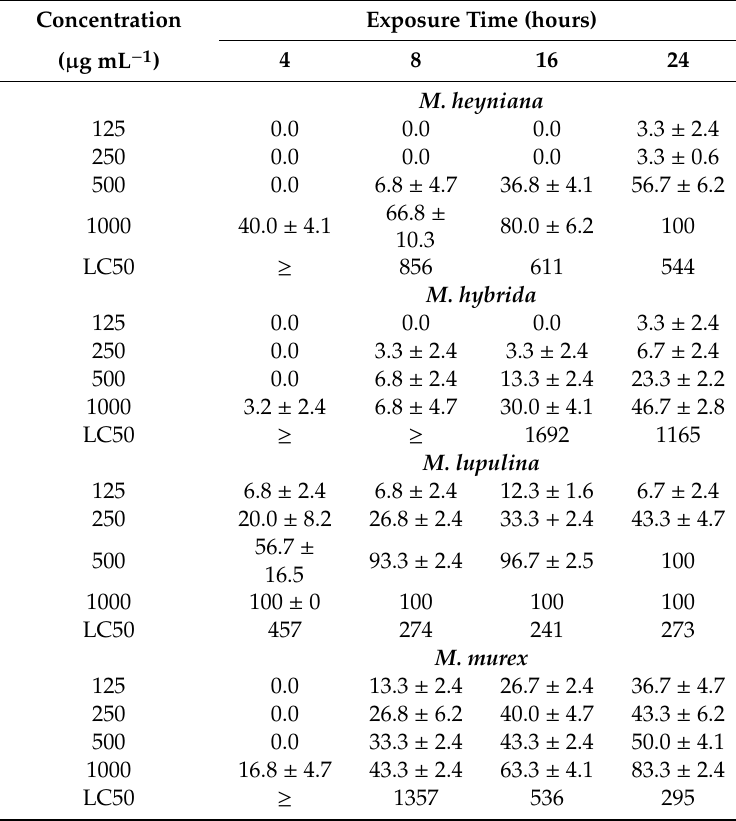
Table 5. Mortality (%) of X. index adult females after 4 to 24 h exposures to 125–1000 µ g mL − 1 solutions of the saponin extract from five di ff erent Medicago species (means ±